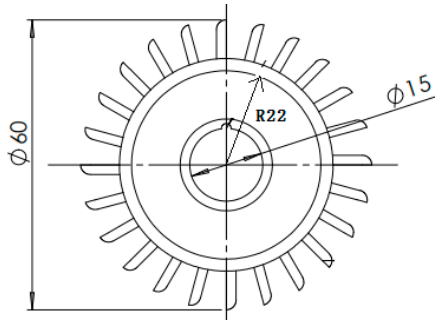
Figure 14. The strain of the water wheel.